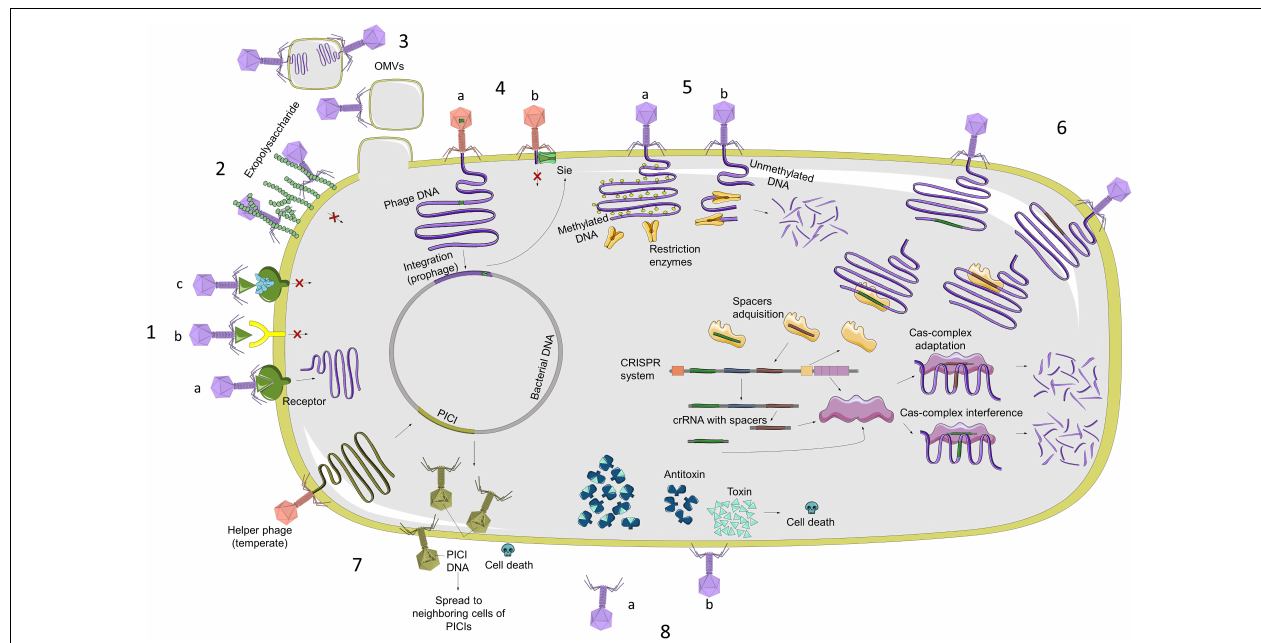
FIGURE 1 | Representation of main mechanisms of bacterial resistance against phage infection (from left in a clockwise sense). 1. (A) Phage recognizes bacterial membrane receptor and can carry out infection; (B) alterations in receptors are produced by mutations and prevent phage from recognizing receptor, so it Will not infect bacteria; (C) bacteria can block recognition by producing inhibitors that bind to receptors. 2. Production of exopolysaccharide or extracellular matrix. 3. OMVs are composed of membrane lipids, membrane proteins, and periplasmic components. Some bacterial species use them as a decoy against phages as a defense mechanism. 4. (A) Bacteria block injection of DNA from other phages, acquiring Sie systems through prophages with this type of protein; (B) once bacterium has prophage in its genome with proteins that code for Sie system, it will be able to block entry of DNA from other phages. 5. (A) R–M system distinguishes between methylated and unmethylated DNA. Restriction enzymes cannot cut methylated DNA, which is also a protection system for bacterial DNA; (B) if phage DNA is not methylated, this system can cut injected DNA. 6. CRISPR-Cas system is an adaptative defense system, which recognizes phage DNA sequences, incorporates them into system, and then produces enzymes that are capable of recognizing these sequences to cut them. 7. PICI system is found in bacterial genome and induced by helper prophages to produce mature phage particles that assemble PICI system itself to kill infected cells and to be able to spread this system to adjacent cells. 8. (A) One of most characterized Abi systems is toxin–antitoxin system. Under normal conditions, bacterium expresses both proteins equally, so cell death does not occur; (B) When organism is subjected to stress situations, such as phage infection, toxin is highly expressed in comparison with antitoxin, causing cell death, which consequently produces a reduction in phage